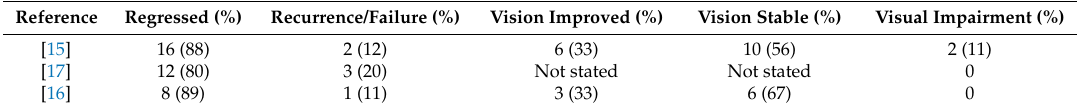
Table 2. Local control rates and visual